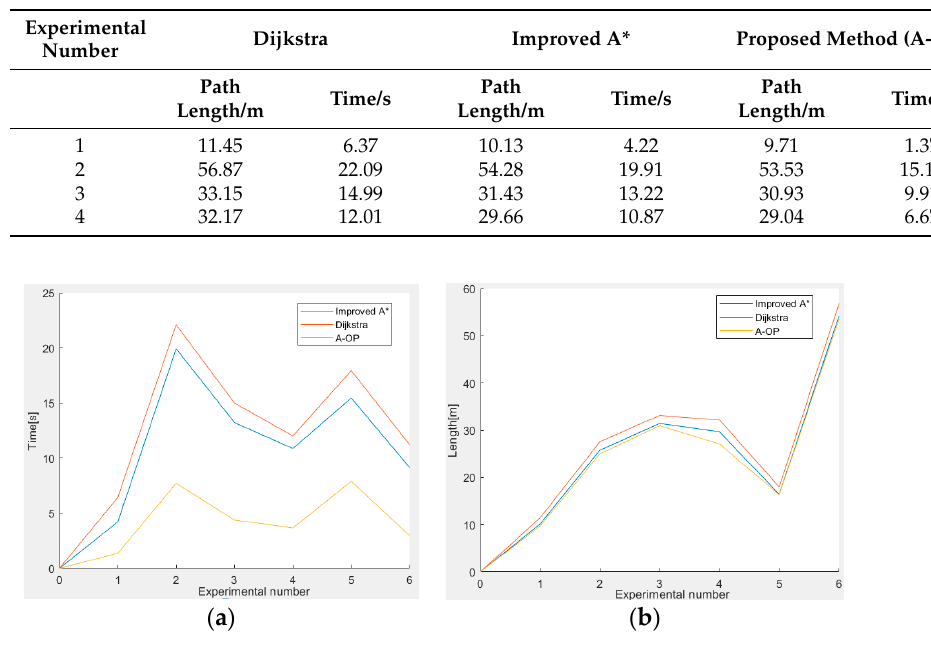
Figure 16. Algorithm performance. ( a ) Planning time, ( b ) Path length. Table 3. Comparison of experimental results of the three algorithms.